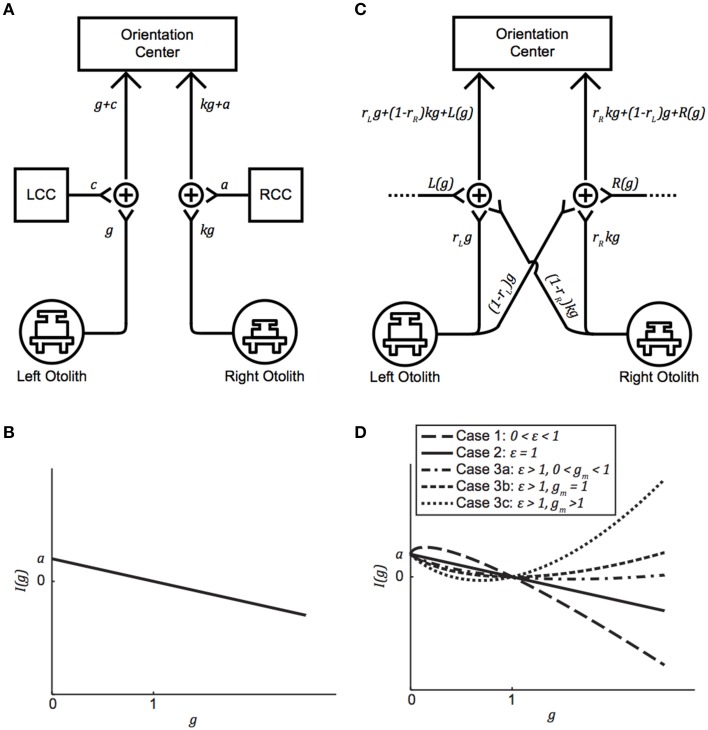
(A) Generalized version of the von Baumgarten and Thümler model for central compensation of an otolith asymmetry. g is the current g-level, k is the otolith asymmetry parameter (0 < k < 1), LCC, and RCC are the left and right compensation centers, respectively, and a and c are the amounts of additive neural compensation required for balance between the left and right sides (a, c ≥ 0). (B) Imbalance as a function of g-level for the von Baumgarten and Thümler model. The direction of imbalance experienced upon an initial change in g-level depends on whether the new g-level is hypo-g or hyper-g. (C) Proposed model for compensation of an inherent otolith asymmetry. rL and rR are the preponderance parameters (0 < rL, rR < 1) and L(g) and R(g) facilitate compensation in novel g-levels. (D) Possible curves for imbalance as a function of g-level, based on the relationships among model parameters, for the proposed model when R(g) = a + b(g)ε. Note that (A) and (C) are simply model block diagrams and are not meant to represent neuro-anatomical pathways.